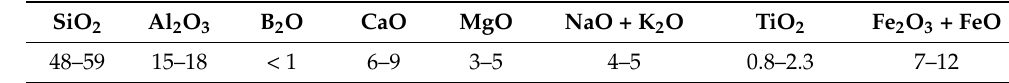
Table 3. Chemical composition of basalt